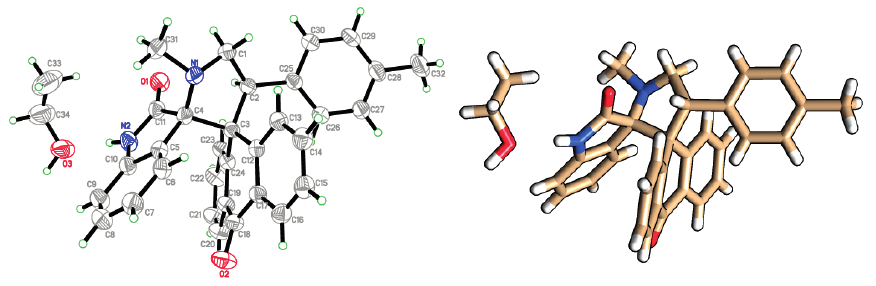
Figure 4. Two views of the X-Ray diffraction study of compound 6h , crystallized with one molecule of